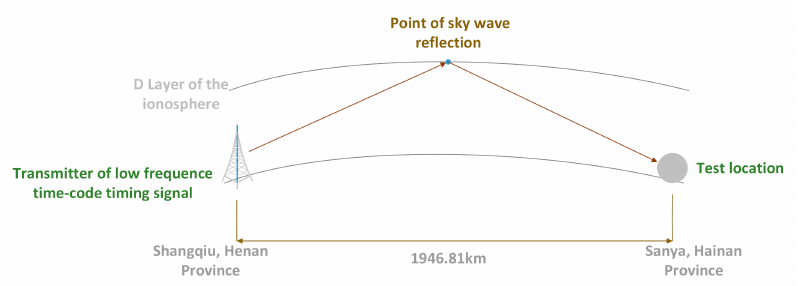
Figure 3. Design of experimental scheme for annular eclipse